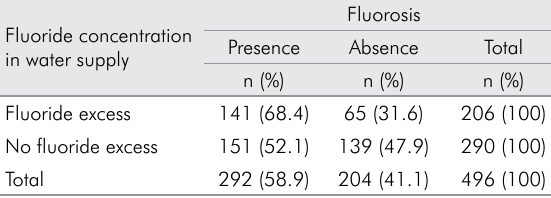
Table 4. Distribution of numerical and percentage values of the 496 twelve-year-old children examined, according to the presence or absence of fluorosis, and water with and without fluorine excess in the water supply. Birigui, SP, Brazil, 2014.